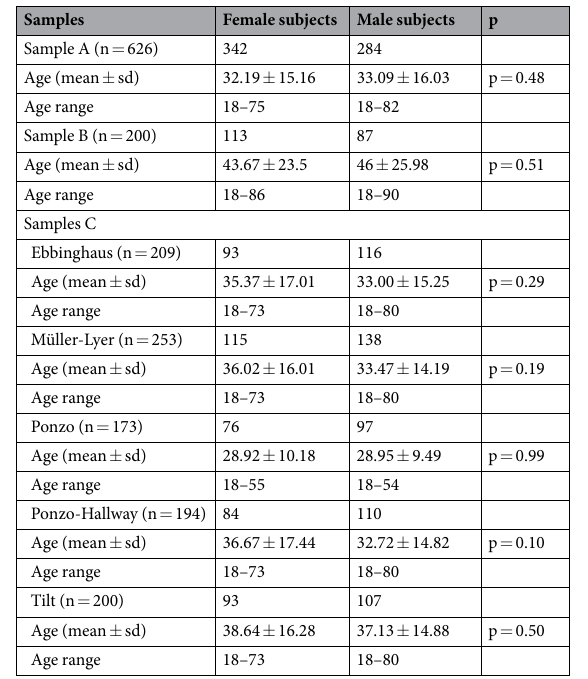
Table 1. Characteristics for the sample of 626 participants (Sample A) that underwent three tests, the subset of 200 participants who performed ten tests (Sample B) and up to 253 participants who were tested with five visual illusions (Samples C; n = 173 to